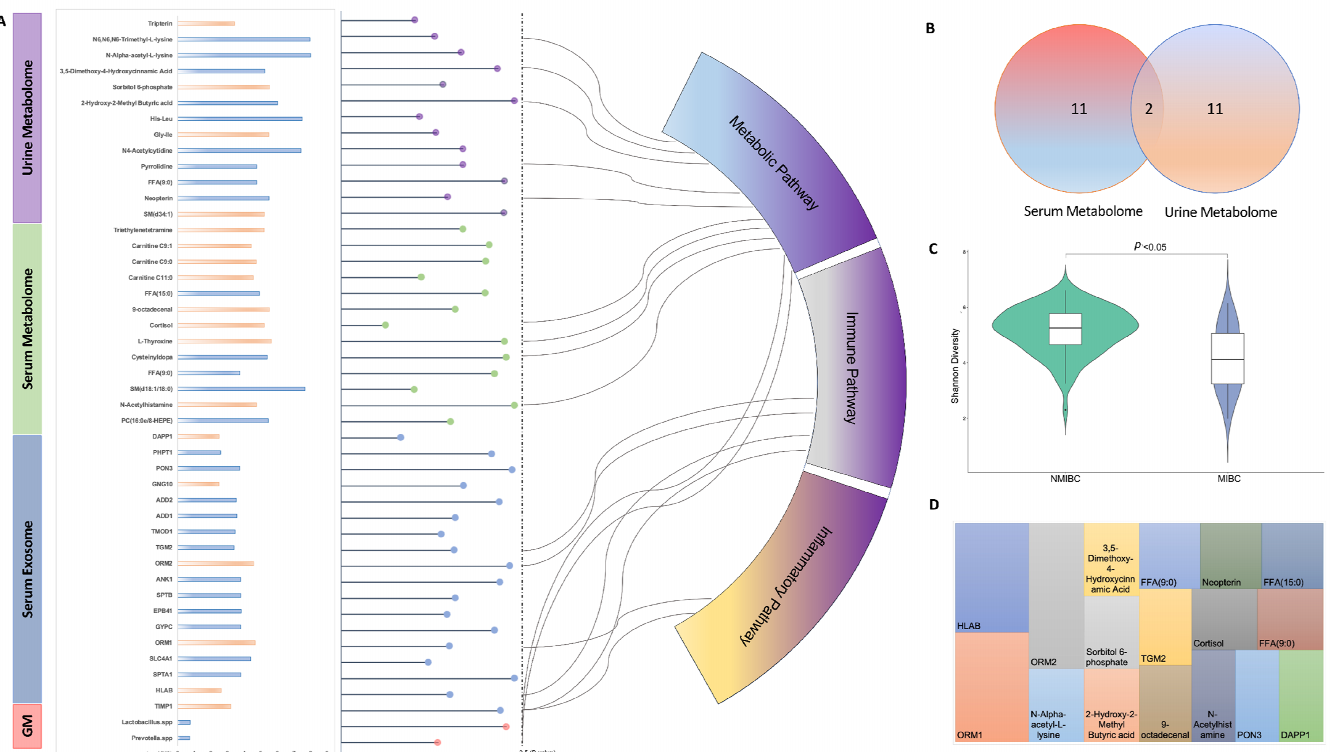
Figure 3. Identification of analytes of multi-omics and functional annotation. ( A ) Identified multi-omics analytes with annotated mechanistic pathways; ( B ) Venn plot of identified metabolites in NMIBC and MIBC; ( C ) Comparison of Shannon diversity between NMIBC and MIBC; ( D ) Established druggable targets from the identified analytes. Abbreviations: EV, extracellular vesicles; GM, gut microbiome; His-leu, Histidine-Leucine; Gly-Ile, Glycyl-Isoleucine; FFA (9:0), Nonanoic acids; SM(d18:1/18:0), Sphingomyelin; FFA (15:0), Pentadecylic acid; DAPP1, Dual adapter for phosphotyrosine and 3-phosphotyrosine and 3-phosphoinositide; PHPT1, 14 kDa phosphohistidine phosphatase; PON3, Serum paraoxonase/lactonase 3; GNG10, Guanine nucleotide-binding protein G(I)/G(S)/G(O) subunit gamma-10; ADD2, Beta-adducin; ADD1, Alpha-adducin; TGM2, Protein-glutamine gamma-glutamyltransferase 2; ORM2, Alpha-1-acid glycoprotein 2; ANK1, Ankyrin-1 OS = Homo sapiens ; SPTB, Spectrin beta chain non-erythrocytic 1; EPB41, Protein 4.1 OS = Homo sapiens ; GYPC, Glycophorin-C OS = Homo sapiens ; ORM1, Alpha-1-acid glycoprotein 1; SLC4A1, Band 3 anion transport protein; SPTA1, Spectrin alpha chain erythrocytic 1; HLAB, HLA class I histocompatibility antigen B alpha chain; Metalloproteinase inhibitor